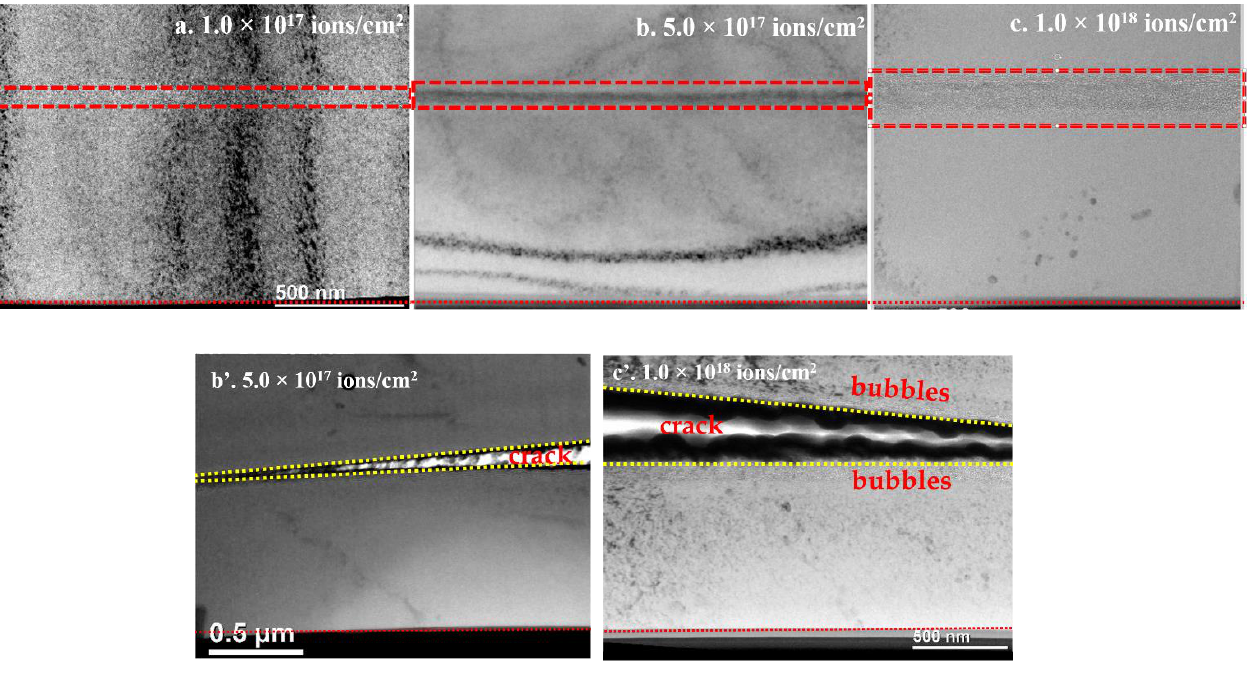
Figure 5. TEM graphs of the whole damage morphology in the samples implanted to 1.0 × 10 17 ions/cm 2 ( a ), 5.0 × 10 17 ions/cm 2 ( b and b’ ), and 1.0 × 10 18 ions/cm 2 ( c and c’ ) at RT. ( b ) and ( c ) are the microstructures under surface without blisters. ( b’ ) and ( c’ ) are the microstructures under surface with blisters. The surface is indicated by a red dotted line. The damage peak zones are labeled by red rectangles in ( a ), ( b ) and ( c ).